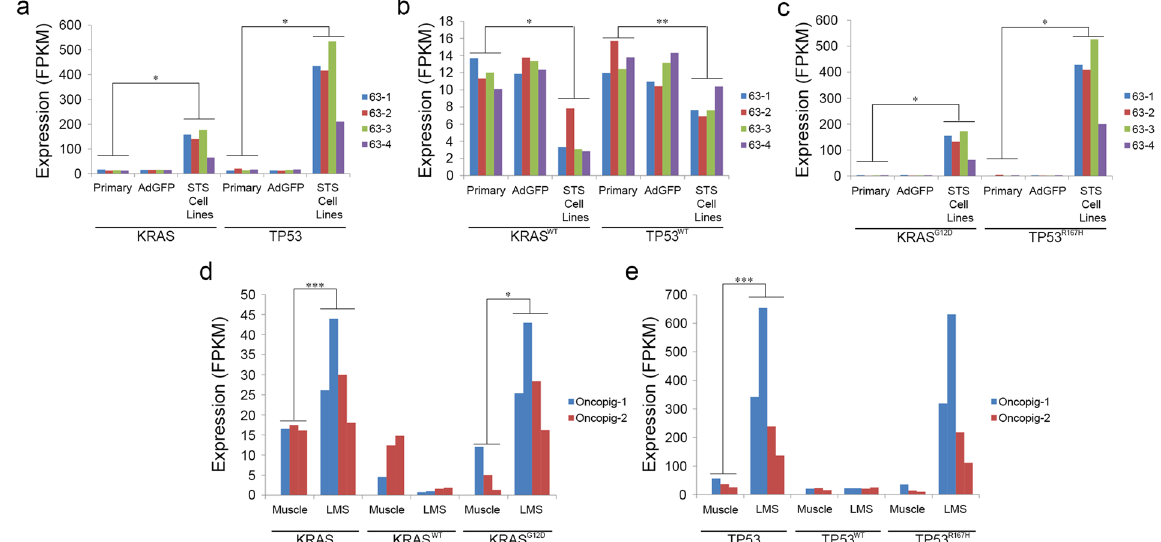
Figure 1. Expression of KRAS and TP53 across Oncopig STS cell lines and leiomyosarcoma tumors. Expression of ( a ) total, ( b ) wild type (WT), and ( c ) mutant KRAS and TP53 in Oncopig primary fibroblasts, AdGFP treated fibroblasts, and STS cell lines. Expression of total, WT, and mutant ( d ) KRAS and ( e ) TP53 in Oncopig skeletal muscle and leiomyosarcomas (LMS). Samples represent biological replicates. Expression values are presented as fragments per kilobase of transcript per million fragments mapped (FPKM). * denotes p < 0.05, ** denotes p < 0.01, *** denotes q <